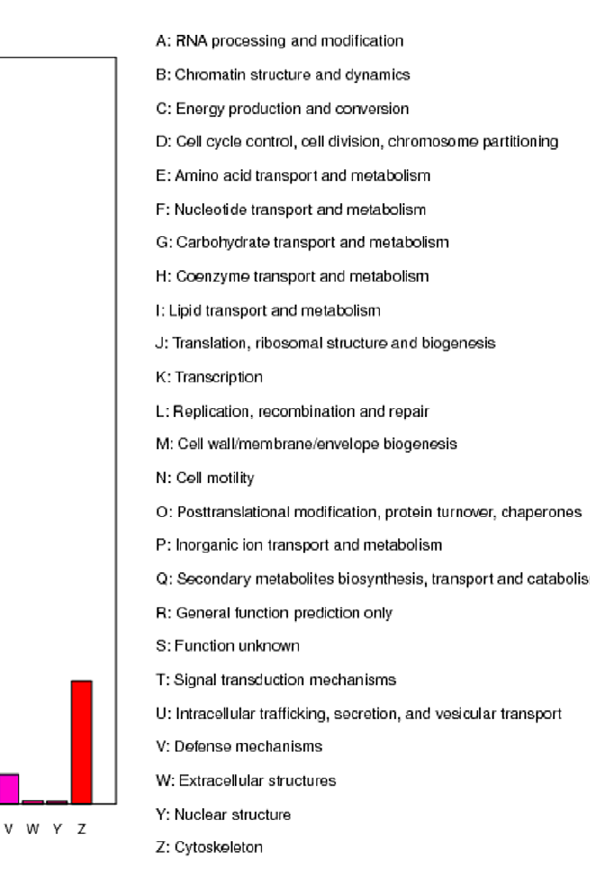
Figure 3. Histogram presentation of clusters of orthologous groups (COG) classification. 18,639 sequences were grouped into 25 COG